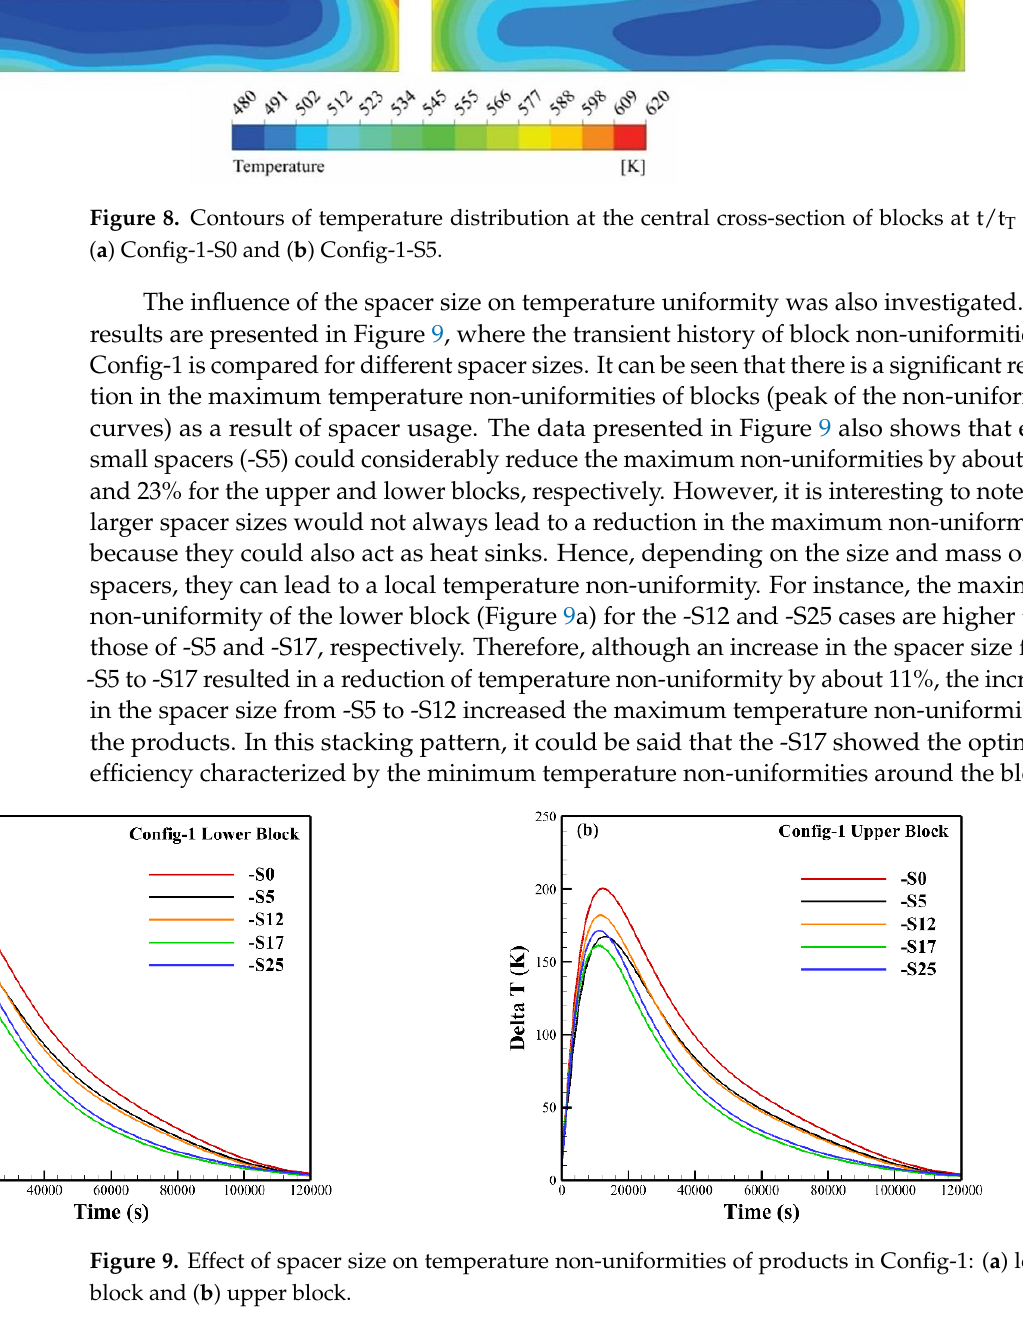
Figure 8. Contours of temperature distribution at the central cross-section of blocks at t/t T = 0.1 ( a ) Config-1-S0 and ( b ) Config-1-S5.